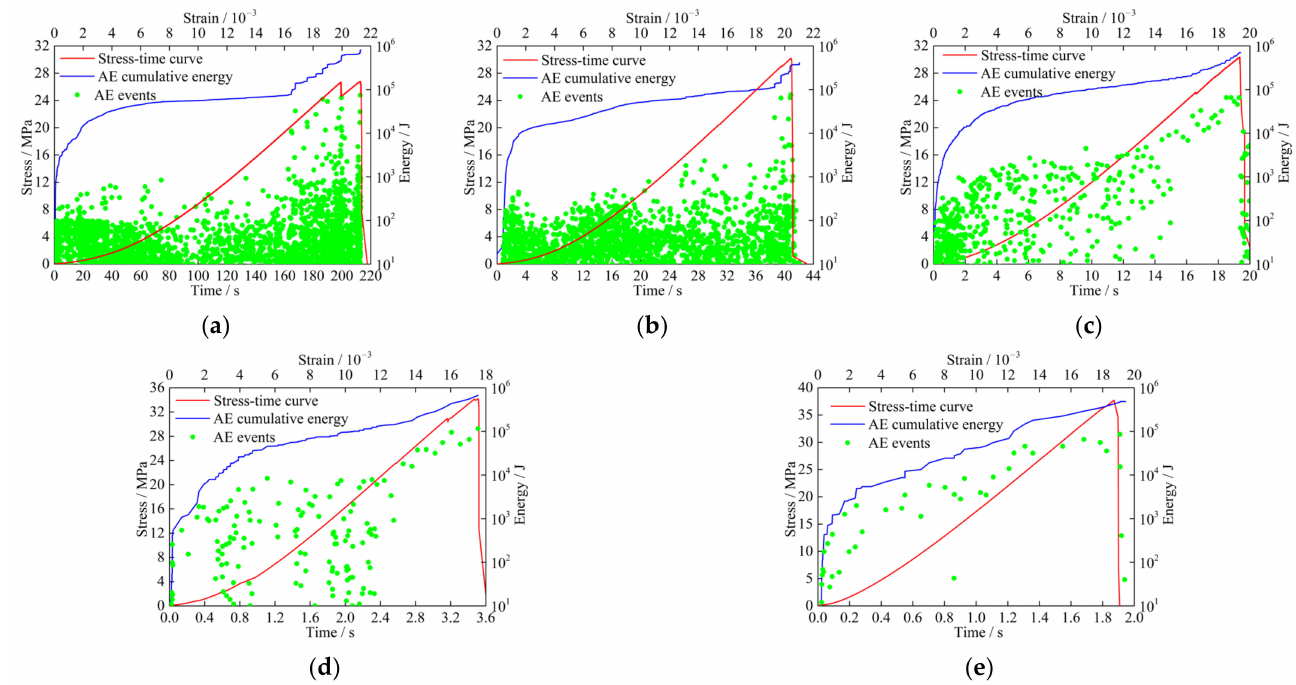
Figure 11. Stress-strain curves and AE characteristics of coal specimens with horizontal bedding: ( a ) 10 − 4 s − 1 ; ( b ) 5 × 10 − 4 s − 1